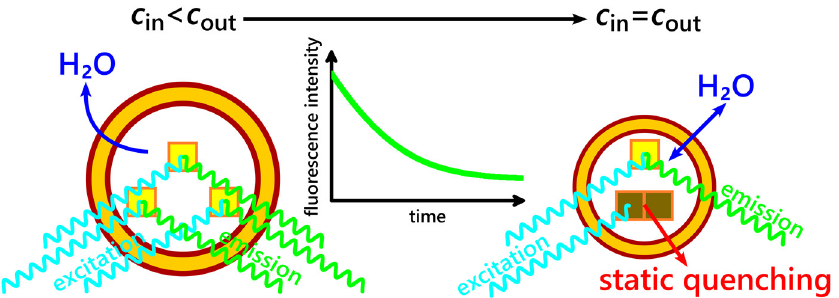
Figure 4. The time course of vesicle volume changes following the introduction of hyperosmotic conditions is accessible via measurements of fluorescence light intensity I f ( t ) of a suspension of vesicles containing aqueous dyes. Commonly, I f ( t ) is measured under an angle of 90°. I f ( t ) decreases because vesicle deflation decreases the distance between the intravesicular fluorophores, and thus, increases their propensity towards self-quenching. For sufficiently high initial fluorophore concentrations (>10 mM for carboxyfluorescein), I f ( t ) is directly proportional to V ( t